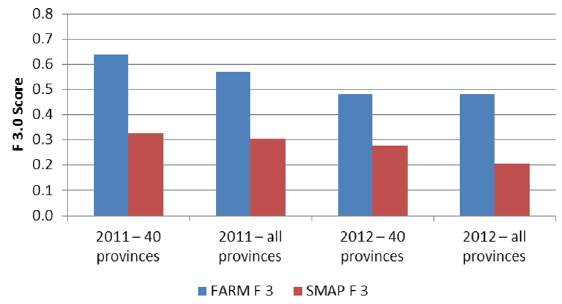
Figure 9. Comparison of F3.0 using four data sets for simple autoregression (SP) and the FARM method used in this